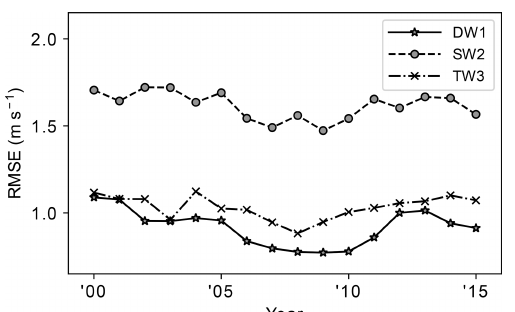
Figure 6. Yearly RMSE between the tidal fields constructed from fits to NAVGEM-360 and NAVGEM-SD sampled at active Super- DARN stations for each year between 2000 and 2016.